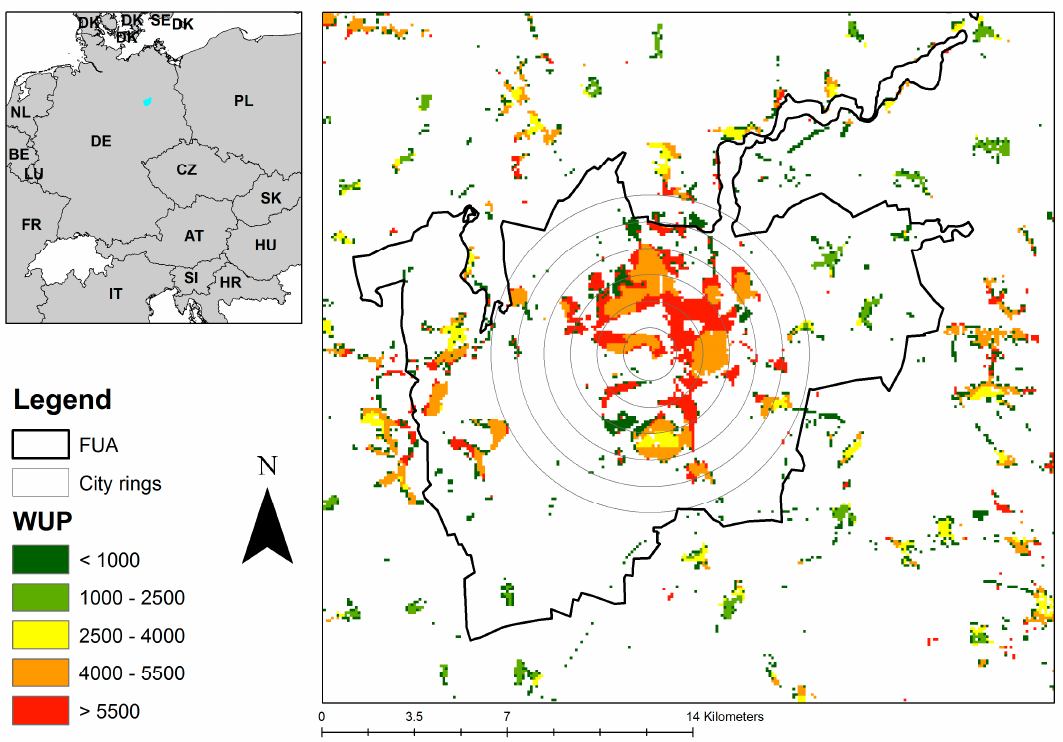
Figure 15. ACWUP for the city of Brandenburg an der Havel, Germany (using a 6 km edge).